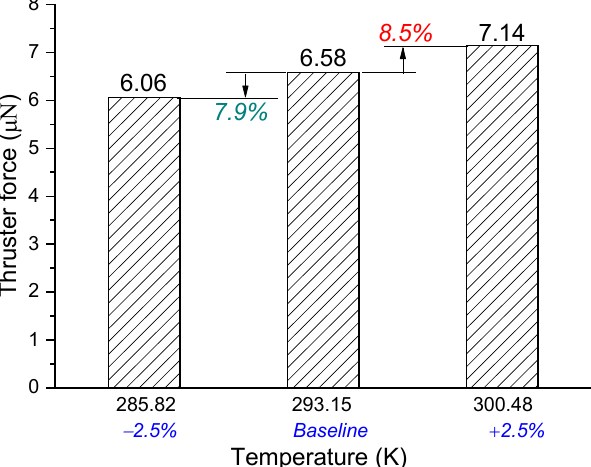
Figure 19. The calculated results of the axial distributions of molecular internal energy ( Left side), momentum ( Middle ) and molecular number density ( Right side) under different gas temperatures.